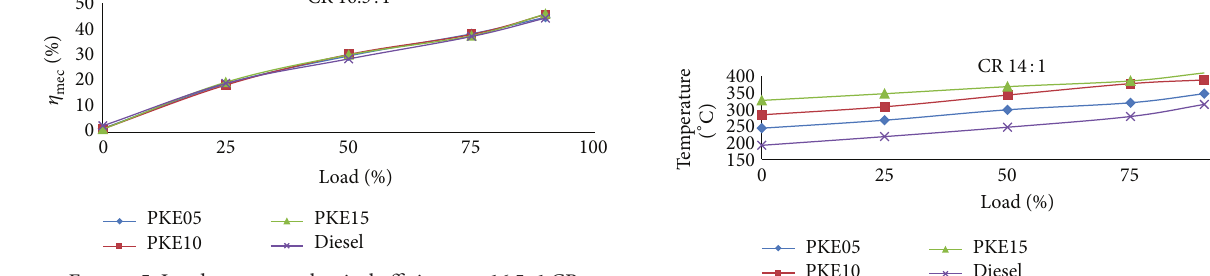
Figure 5: Load versus mechanical efficiency at 16.5 : 1 CR.